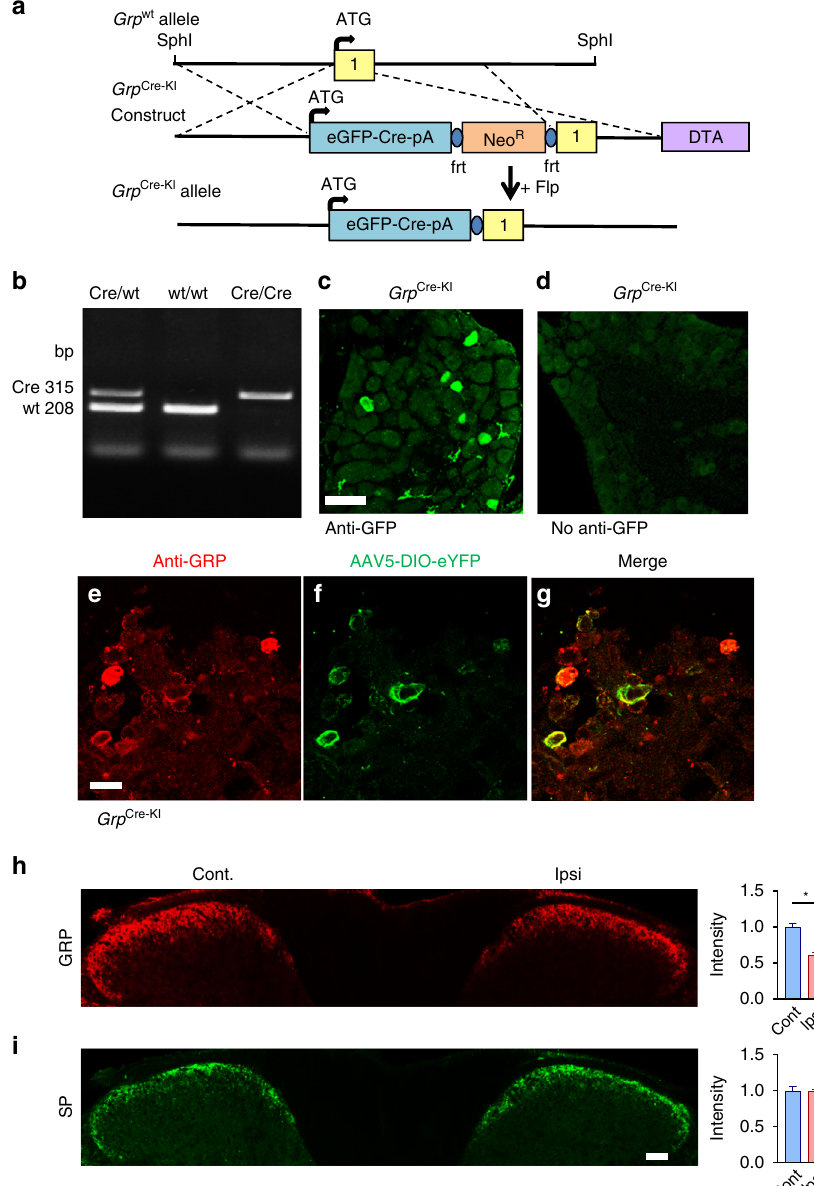
Fig. 1 Validated expression of Grp and Cre in Grp Cre-KI sensory neurons. a Schematic of targeting strategy to knock in eGFP-Cre cassette in Grp allele to generate Grp Cre-KI mice. b Gel electrophoresis of genotyping PCR from Grp Cre/wt, wt/wt, and Cre/Cre samples. c eGFP IHC from DRG section of an adult Grp Cre-KI mouse. d Image of eGFP epi fl uorescent signal (no GFP antibody) in Grp Cre-KI DRG. e – g GRP IHC ( e ) and eYFP fl uorescent image ( f ) from DRG section of an adult Grp Cre-KI mouse that received AAV5- EF1 α -DIO-eYFP injection into the DRG for 3 weeks. Scale bar, 20 μ m. h and i IHC of GRP ( h ) and SP ( i ) in cervical spinal sections from WT mice following i.d. injections of CQ (200 μ g). Scale bar, 100 μ m. Data are presented as mean ± s.e.m., n = 3 mice and 9 sections. Source data are provided as a Source Data fi